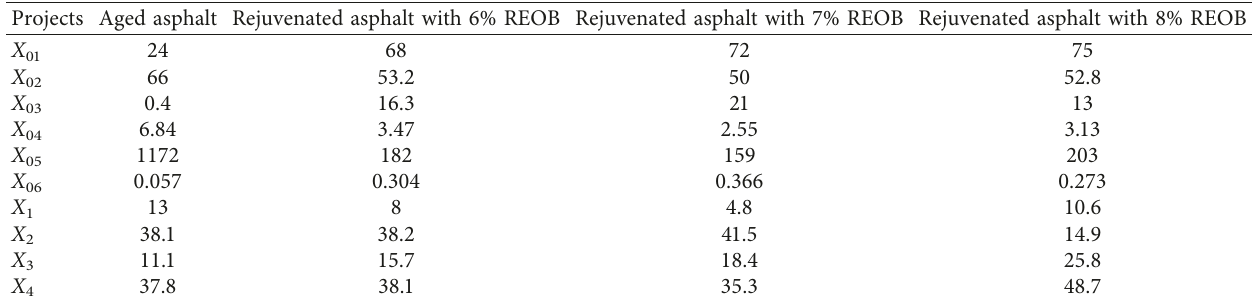
Table 6: Raw data of of aged asphalt and rejuvenated asphalts with